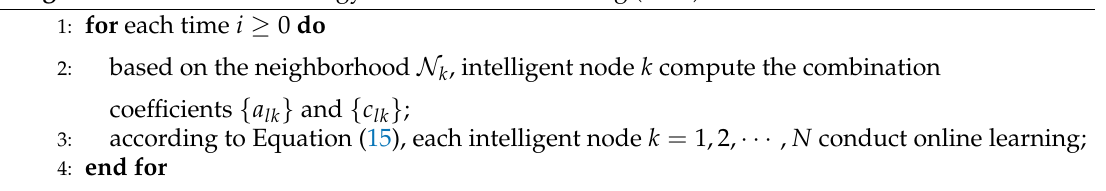
Algorithm 4: Diffusion strategy for distributed learning